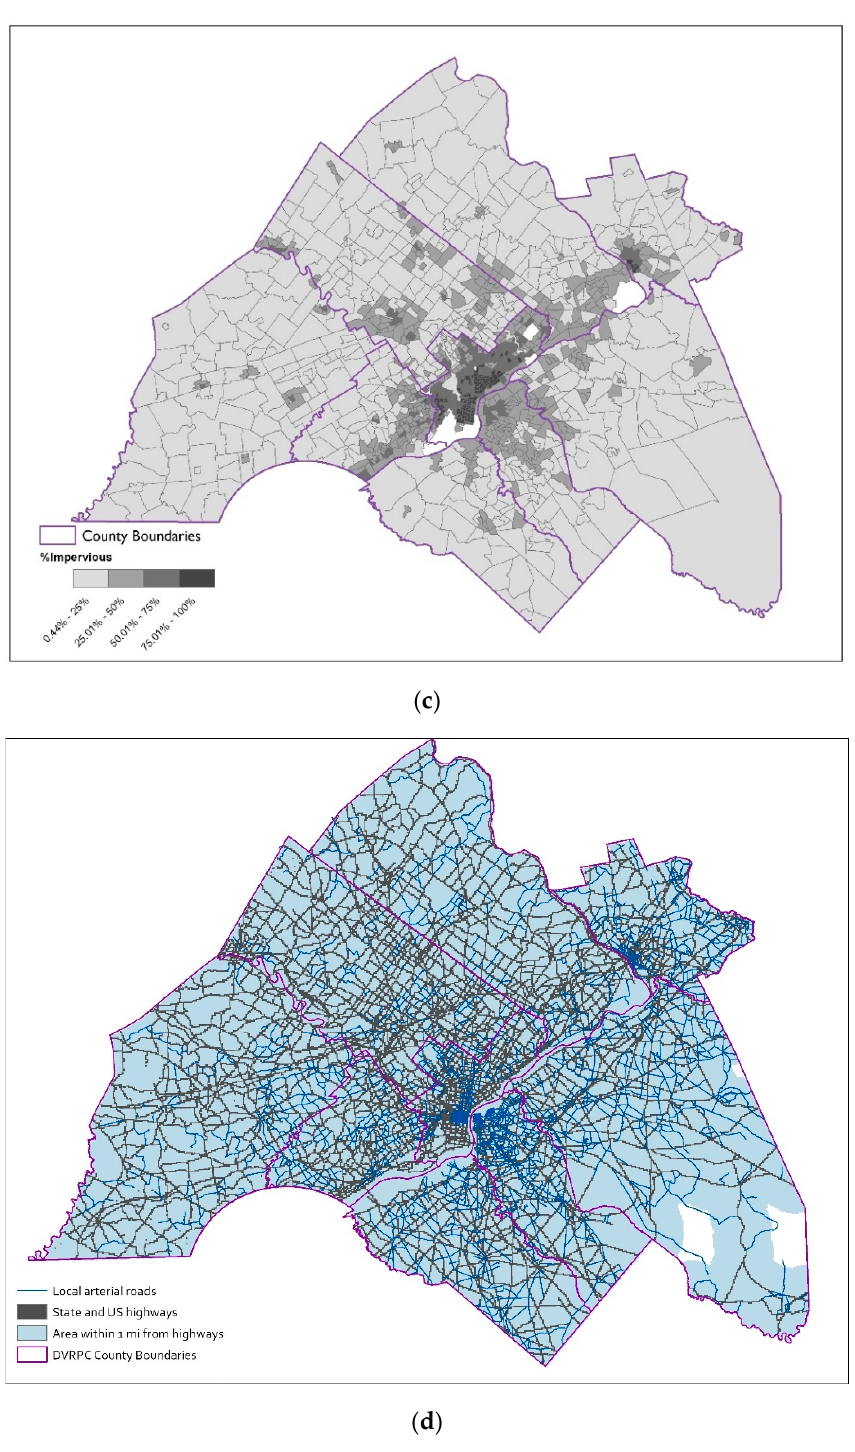
Figure 1. ( a ) The study area, which includes the nine ‐ county Delaware Valley Region, is spread across New Jersey (shaded in green) and Pennsylvania (shaded in yellow) (Data source: Delaware Valley Regional Planning Commission). ( b ) Combined percentage of African American and Hispanic population in the study region. Darker shades show higher percentages in urban centers. ( c ) Imperviousness, expressed as a percentage of total tract area. Darker shades denote higher concentration of imperviousness. ( d ) Regional road network infrastructure in the study region. Area colored in sky blue is within a 1 ‐ mile buffer from a major highway.